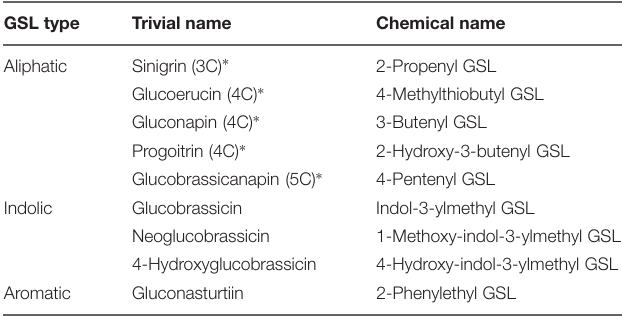
TABLE 1 | Nomenclature of the individual glucosinolates identified in shoots and roots of Brassica juncea and B. rapa. GSL